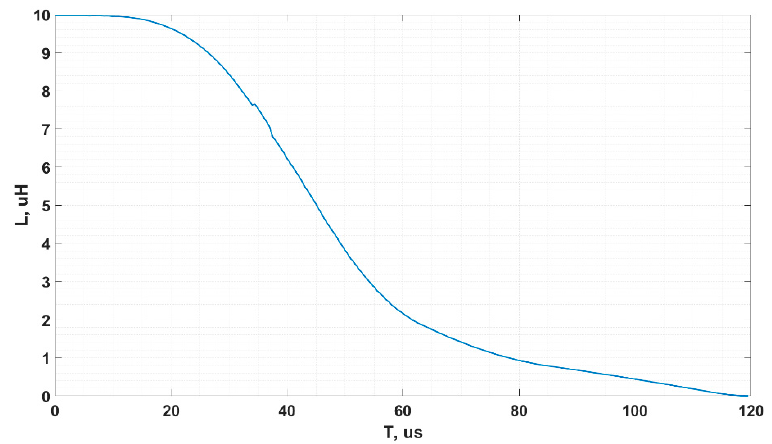
Figure 3. Dynamics of EMG inductance output at the operation on a load.